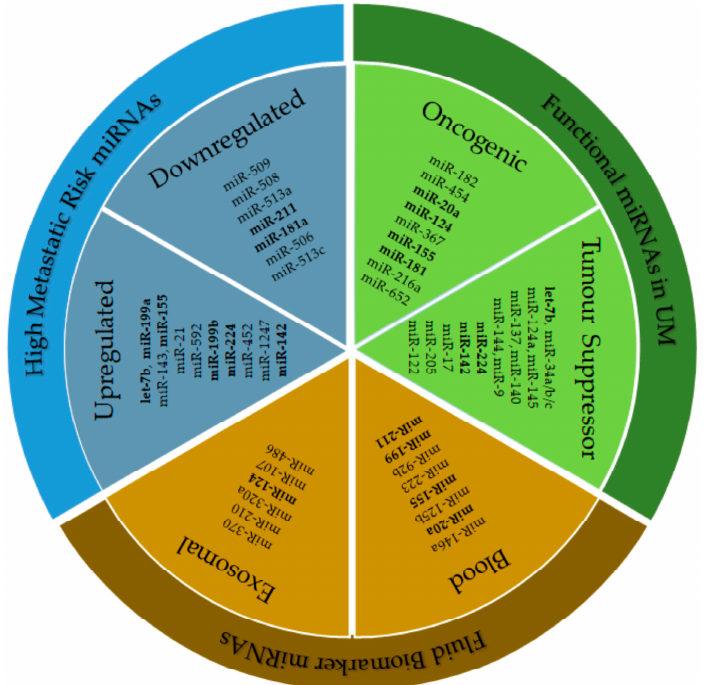
Figure 2. Selected miRNAs reported in uveal melanoma (UM) studies that have been examined functionally and are associated with disease progression or increased metastatic risk. These data include all functional miRNAs examined in Tables 1 and 2, miRNAs identified as fluid biomarkers of disease progression or metastasis as well as miRNAs identified as associated with increased metastatic risk from both UM tissue samples and in silico data-mining studies. All data presented are significantly changed miRNAs in the study setting and have been cross-compared between studies to identify important miRNAs. Common miRNAs identified in the different study settings are in bold.